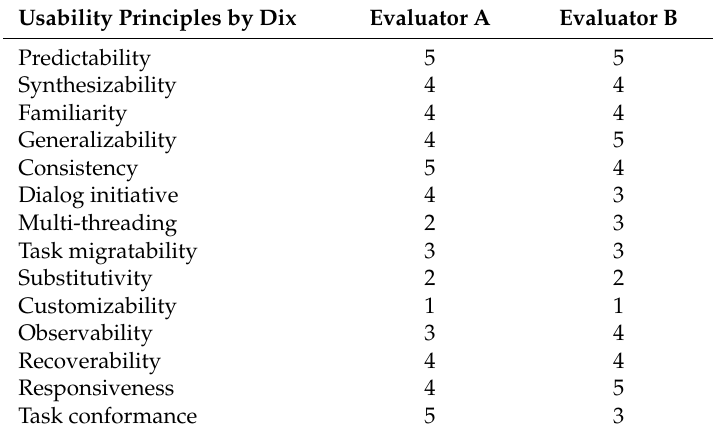
Table 3. Usability principles by Dix usability